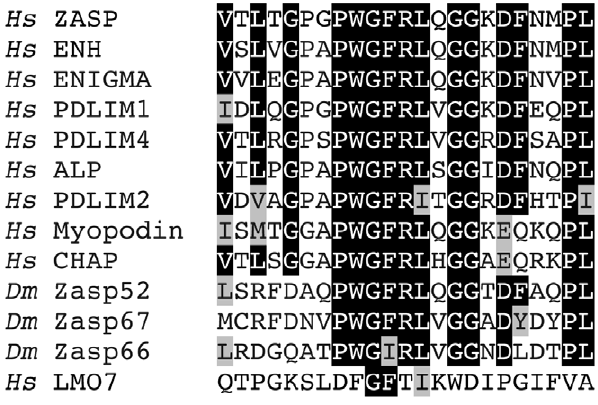
Figure 5. The Zasp PDZ domain. Alignment of 23 amino-terminal amino acids in the PDZ domain starting with V5 for ZASP. Mutagenesis demonstrated the importance of ZASP/Cypher residues G14 and F15 in binding a -actinin 2 [11]. A structural study predicted ZASP residues W13, G14, F15, R16, and L17 to form direct non-covalent interactions with the carboxy-terminal EF hands 3 and 4 of a -actinin 2 [16]. All human and Drosophila family members are shown and additionally LMO7, the closest relative that lacks this motif. Identical amino acids are highlighted in black, similar amino acids are highlighted in grey. Hs , Homo sapiens ; Dm , Drosophila melanogaster .